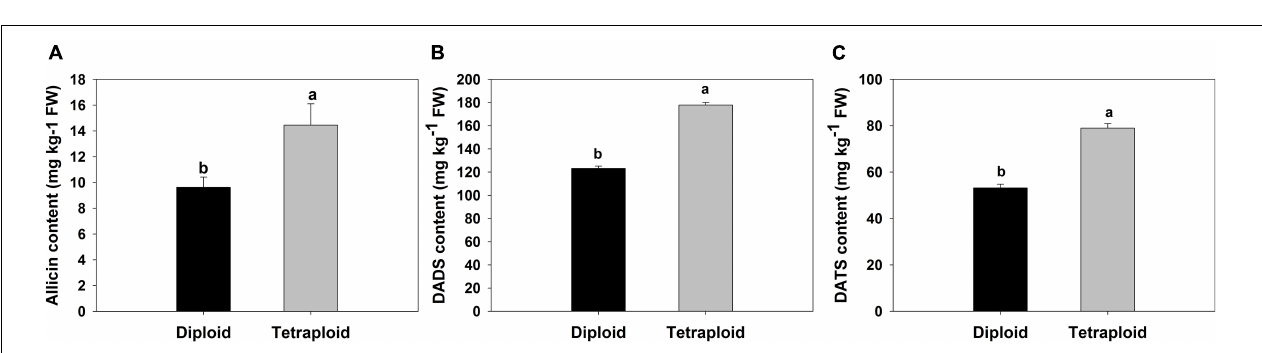
FIGURE 6 | Comparison of physiological compounds. (A) Soluble sugar. (B) Reducing sugar. (C) Soluble protein.